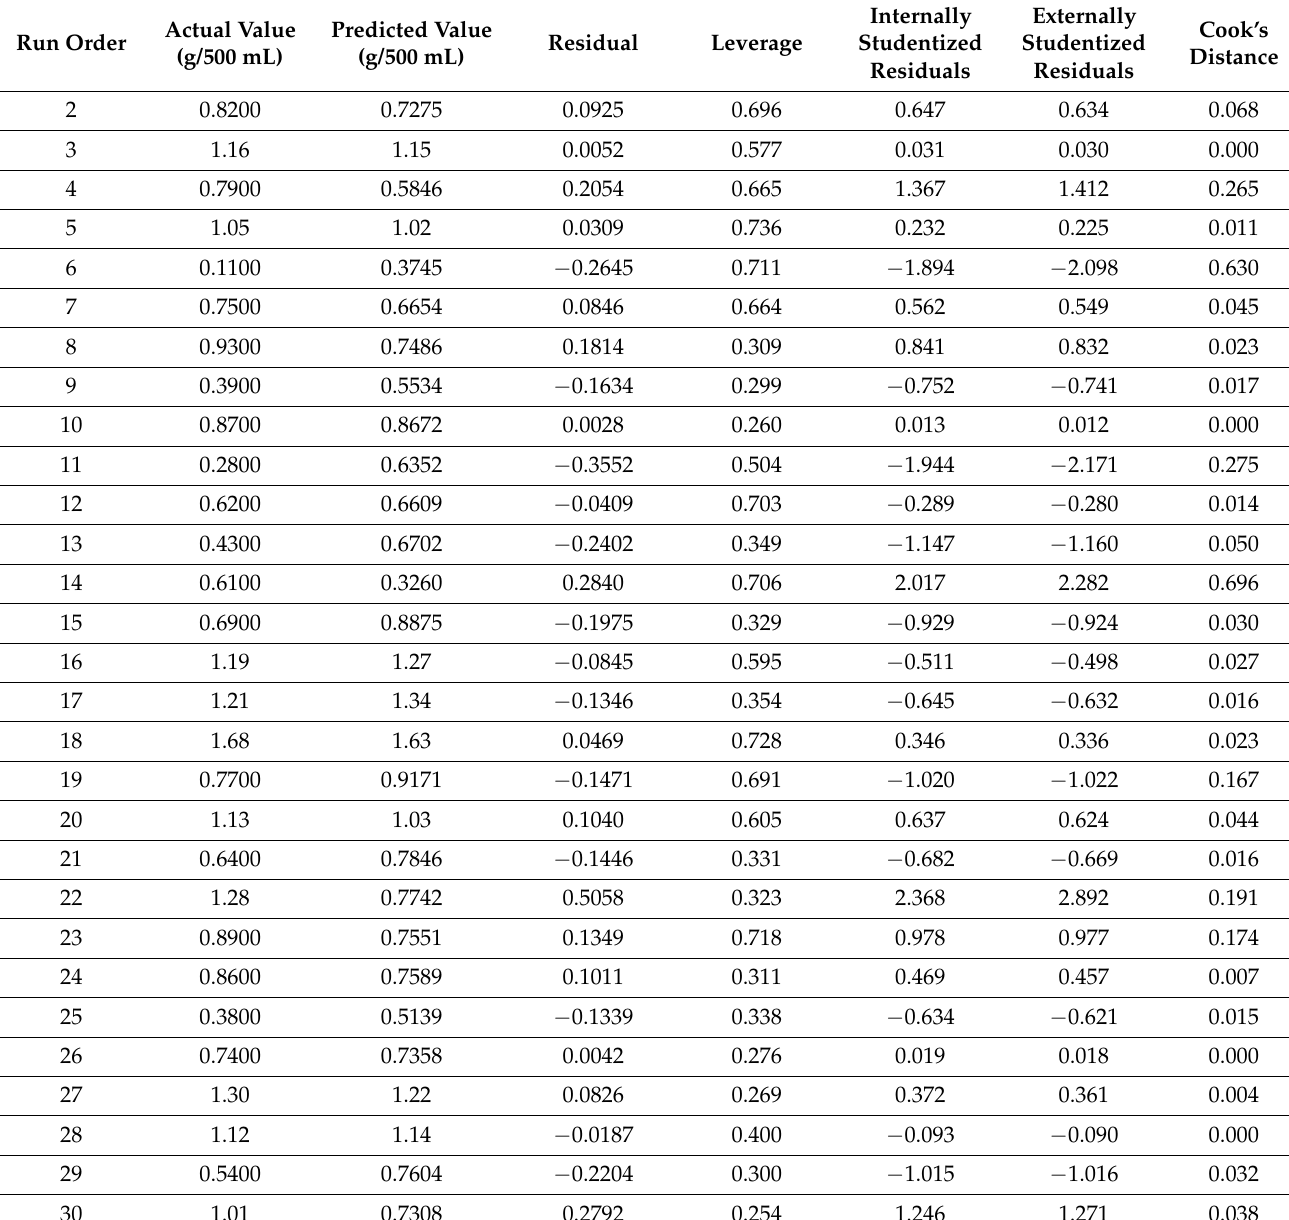
Table 3. Statistical analysis of actual results and predicted